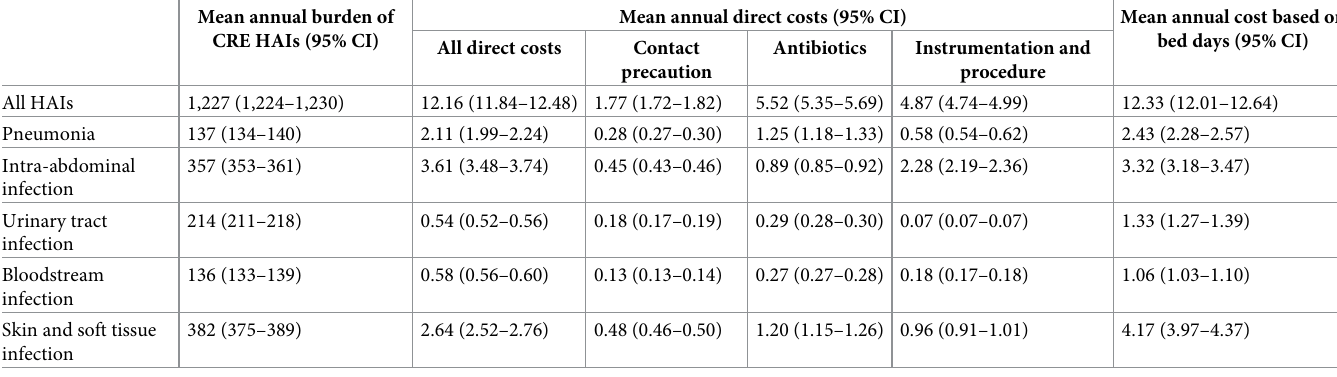
Table 4. Burden and costs of CRE HAI in million (SGD)